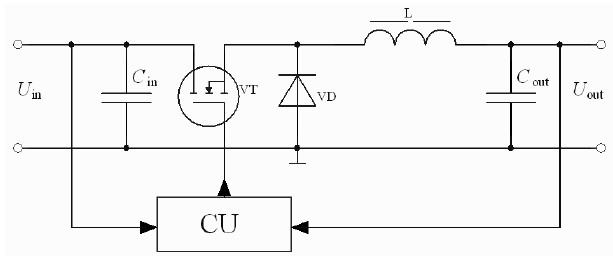
Figure 1. The schematic diagram of the buck converter